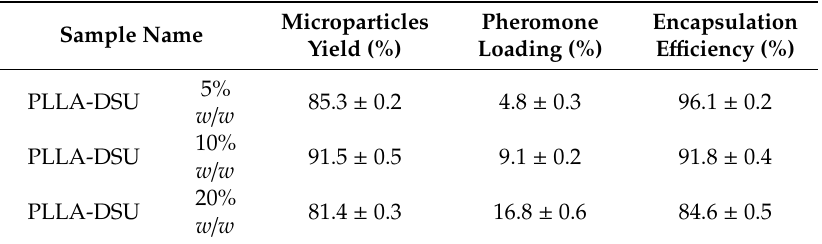
Table 1. Encapsulation yield, loading and e ffi ciency percentages of PLLA on di ff erent amounts (%) of encapsulated DSU after